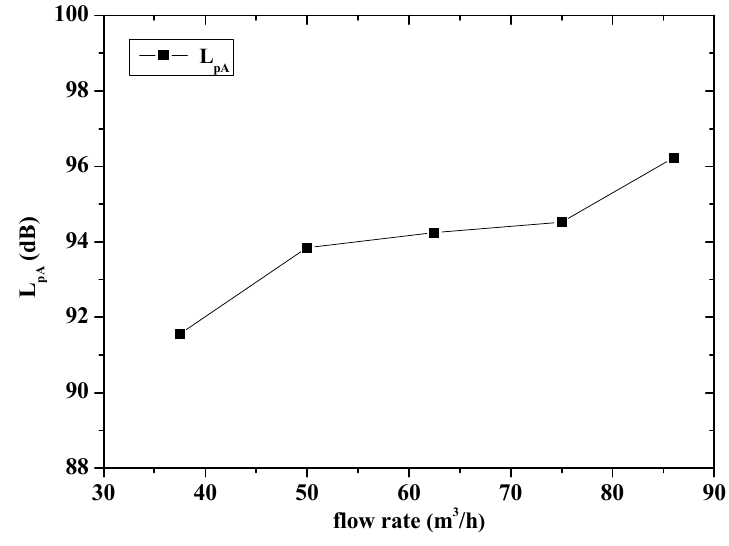
Figure 12. L pA changing curve with flow rate (2900 rpm).